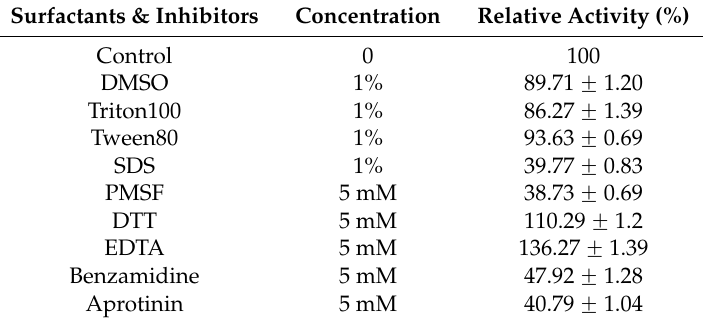
Table 5. Effect of various inhibitors and surfactants on trypsin